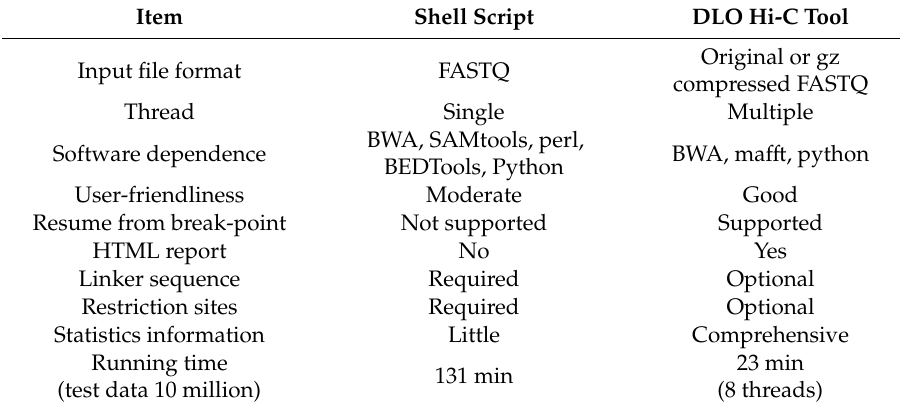
Table 5. Comparison of the DLO Hi-C tool with the original shell script.